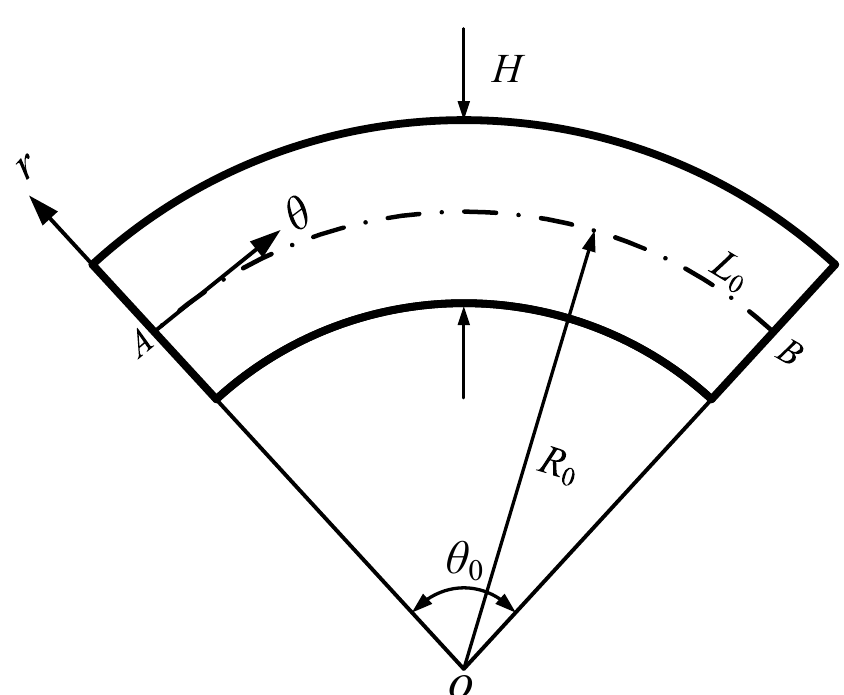
Figure 1. Sketch of the FG-GPLRC circular arch and the polar coordinate system.